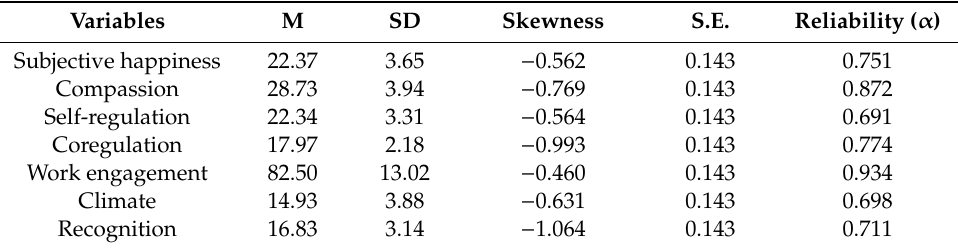
Table 1. Main descriptive statistics of